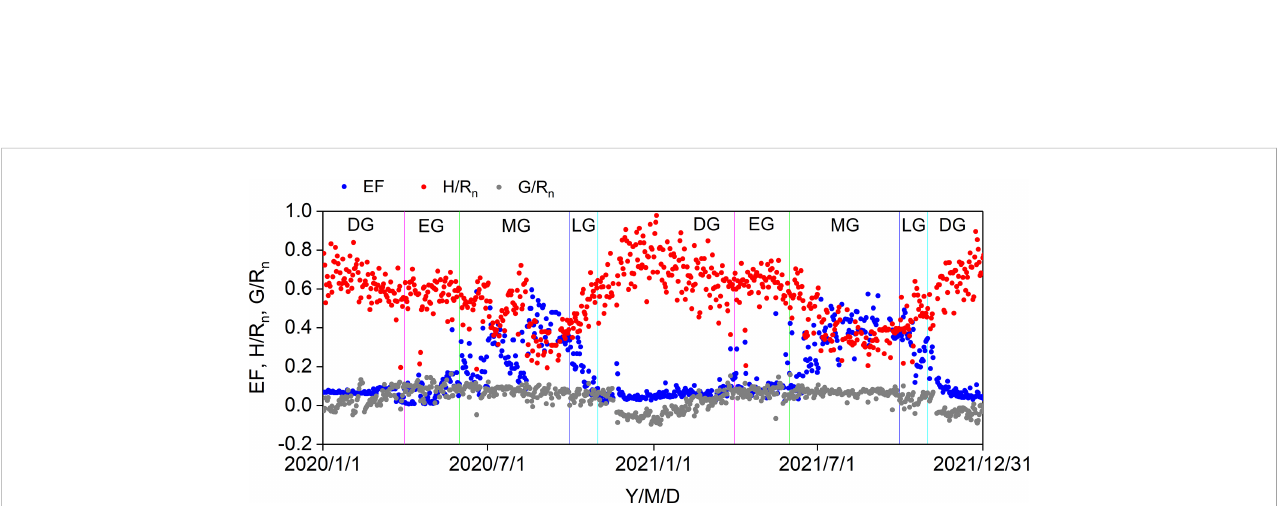
FIGURE 5 Diurnal cycle of monthly average net radiation (R n ), sensible heat fl ux (H), latent heat fl ux (LE), and soil heat fl ux (G) in (A) 2020 and (B)